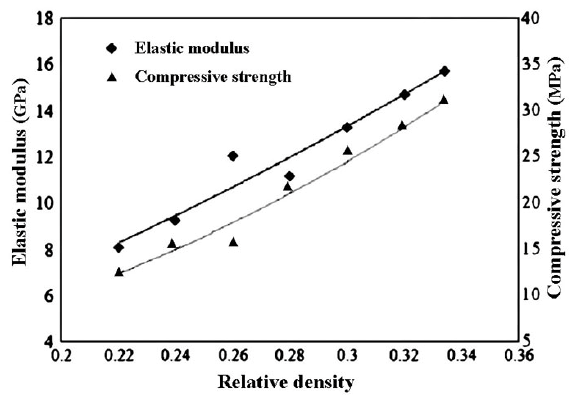
Figure 13. Influence of density on mechanical properties of porous Ti-10Mo alloys ([189], modified). Reprinted with permission from [189]. Copyright 2013